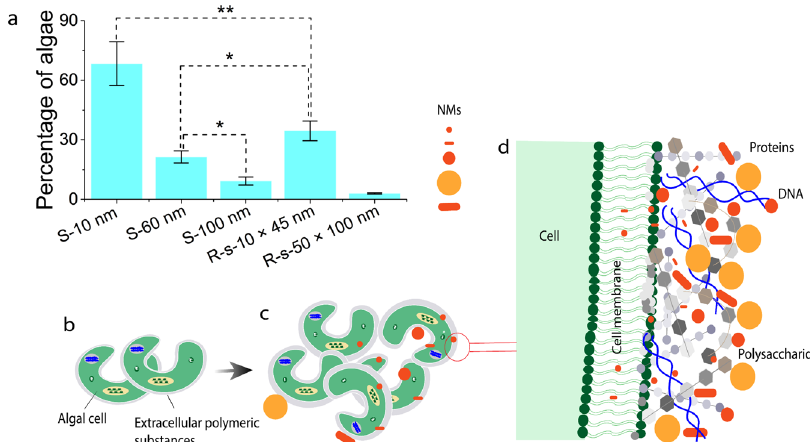
Fig. 1 Association of Au-nanomaterials (Au-NMs) with algal cells. a Percentage of algal cells that have associated Au-NMs as a function of particle size and shape. NMs, nanomaterials; S, spherical; R-s, rod-shaped. Error bars = SD ( n = 15), biologically independent samples. Data were analysed using one- way ANOVA with Duncan ’ s post hoc test (** P < 0.001; * P < 0.05). b Pseudokirchinella subcapitata algae with a thin layer of extracellular polymeric substances (EPS) around each cell in the natural condition. c The algal cells are exposed to Au-NMs of different sizes and shapes. The thickness of the EPS layer is expected to increase due to the exposure to Au-NMs as reported for other stressors 64 . The association of the Au-NMs is randomly distributed between the cells of the given population. d Penetration of Au-NMs of different sizes and shapes in the algal cell membrane and the EPS layer on the surface of the cells containing different biomolecules (e.g., polysaccharide, DNA, and proteins) excreted from the cell. The schematic shows how EPS may control the penetration of Au-NMs as a function of particle size and shape, where the smaller particles can penetrate, whereas the bigger or longer particles are trapped in the EPS. It is noteworthy that different elements in the schematic are not drawn to